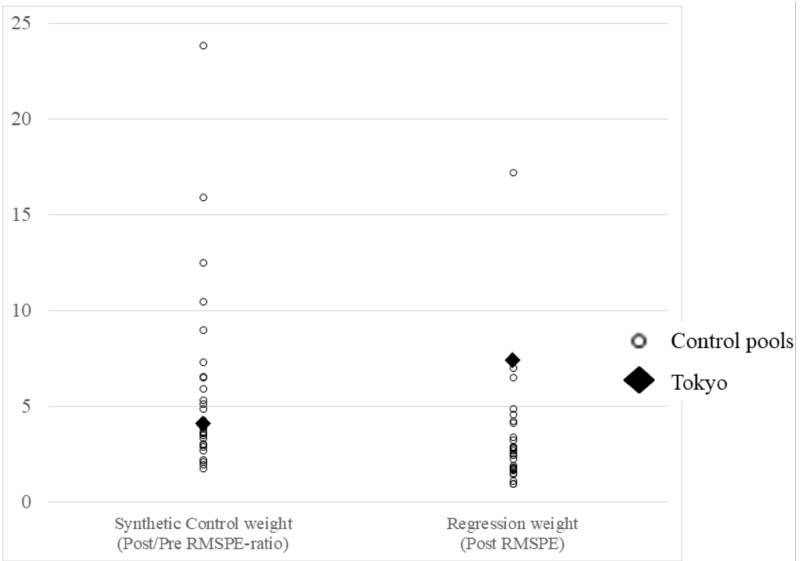
Figure 10. Total results of the synthetic control weights and regression weights. RMSPE—root mean square prediction error. Tokyo ranks 15th in the synthetic control weight analysis and second in the regression weight